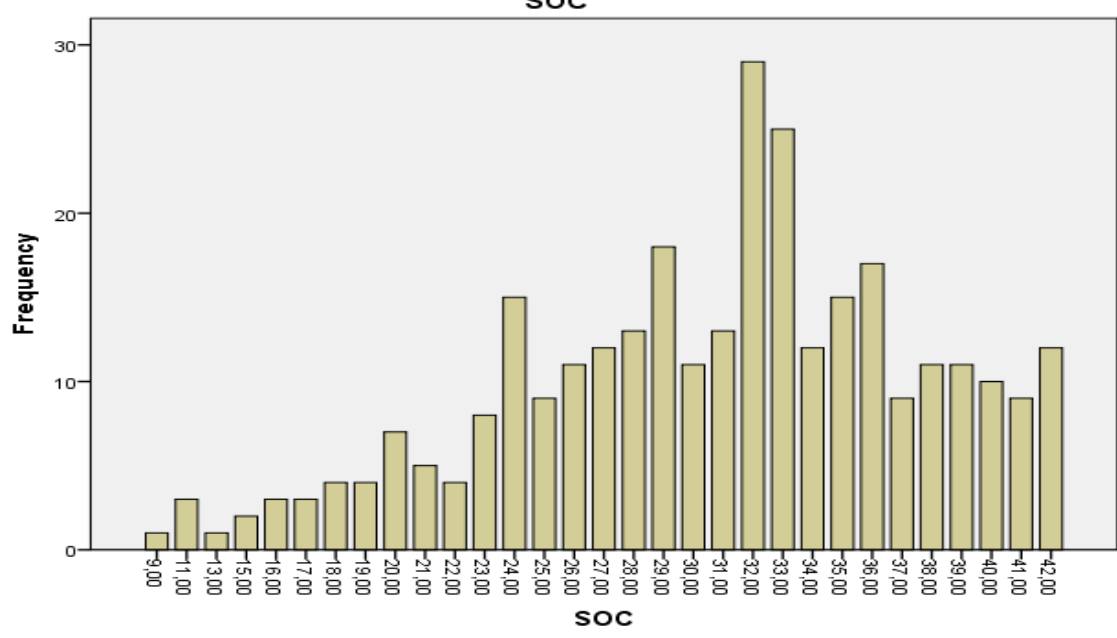
Fig. 1. Mean distribution of SOC among respondents Emerged from the statistical